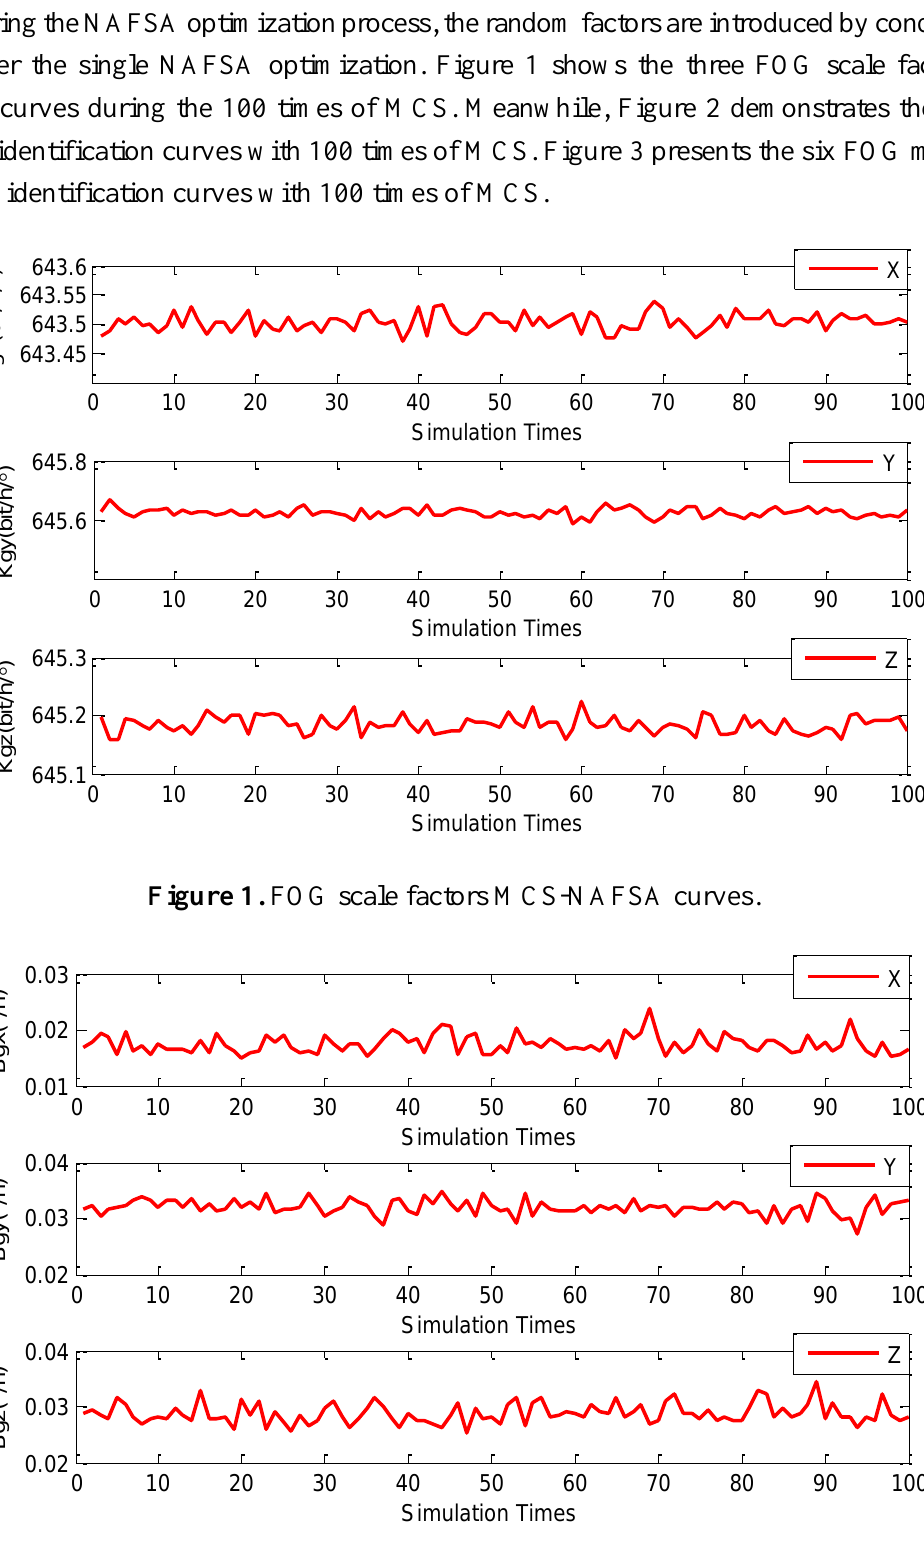
Figure 2. FOG biases MCS-NAFSA